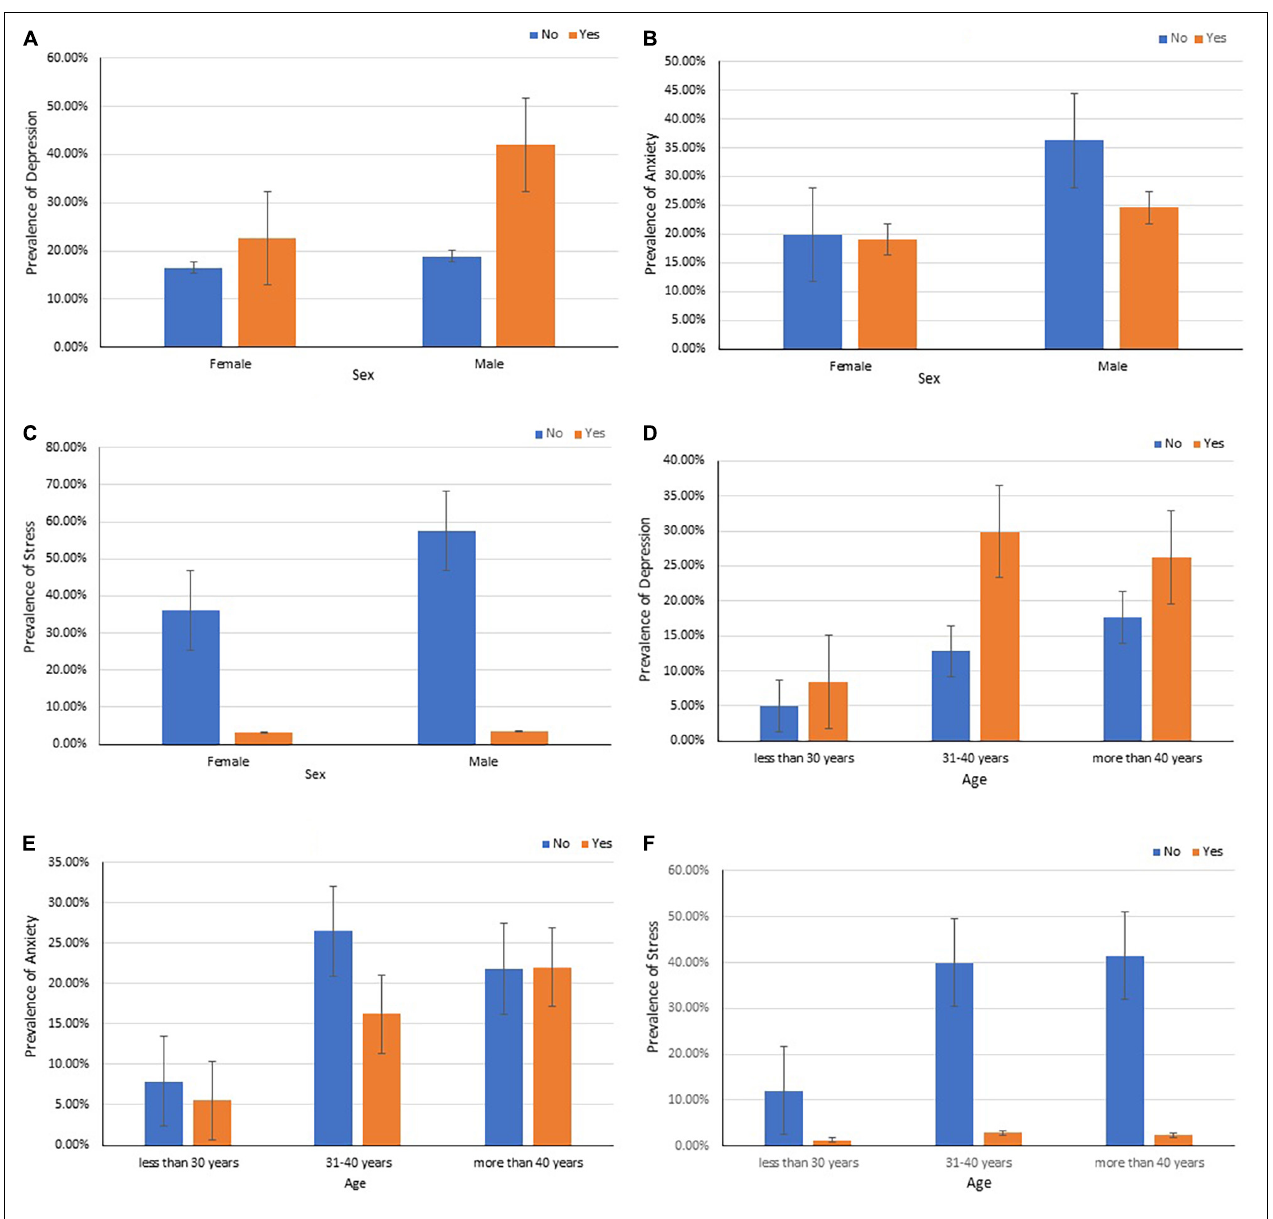
FIGURE 1 | Prevalence and standard error of depression (A,D) , anxiety (B,E) , and stress (C,F) among teachers in Bangladesh by sex and